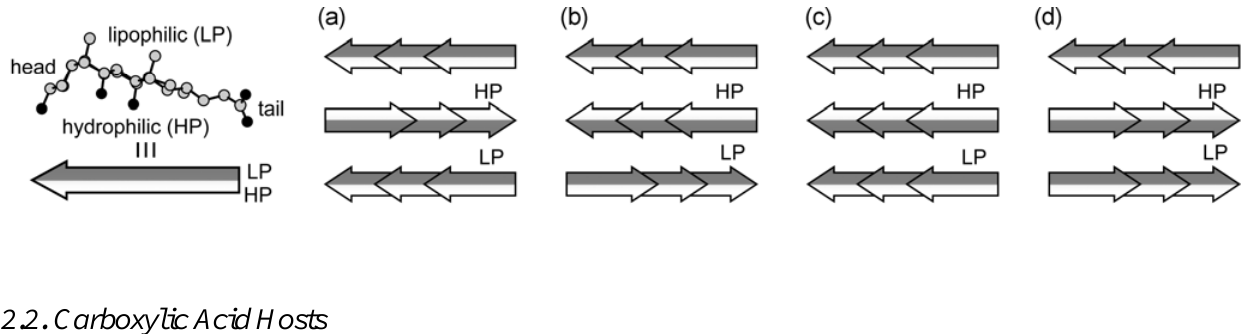
Figure 4. Asymmetric layers with a tail-to-head alignment on their hydrophilic side (HP) and lipophilic side (LP). Four kinds of the arrangements of the layers; anti-parallel on both HP and LP (a), parallel on HP and anti-parallel on LP (b), anti-parallel on both HP and LP (c), and anti-parallel on HP and parallel on LP sides